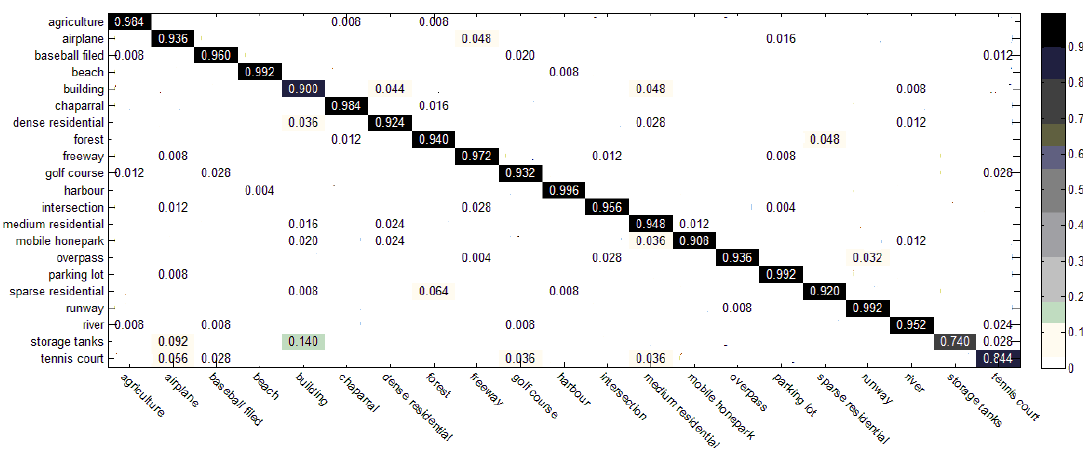
Figure 14. Confusion matrix for the proposed algorithm using UC_MERCED land-use dataset.